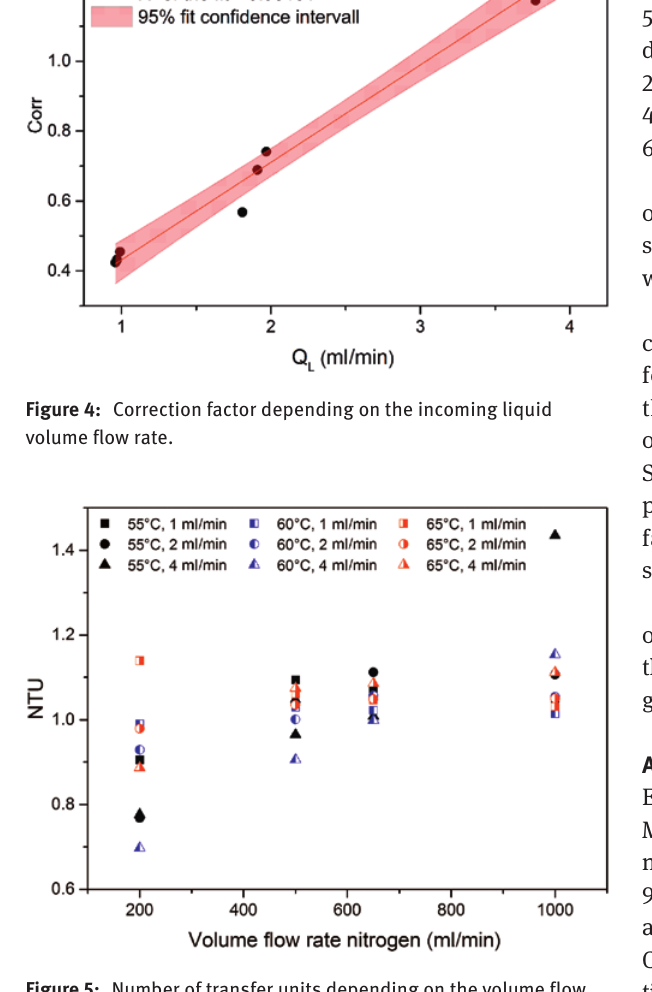
Figure 5: Number of transfer units depending on the volume flow rate of nitrogen at incoming liquid flow rates of ca. 1 ml/min, 2 ml/min, and 4 ml/min and temperatures of 55 ° C, 60 ° C, and 65 °